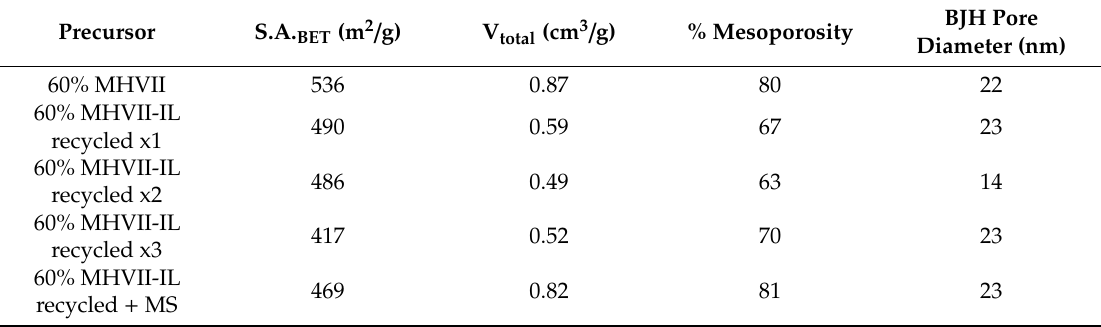
Table 6. Nanoporosity data of carbons obtained from Maize + Hylon VII (60 wt% amylose) with pure and recycled ionic liquid (IL).